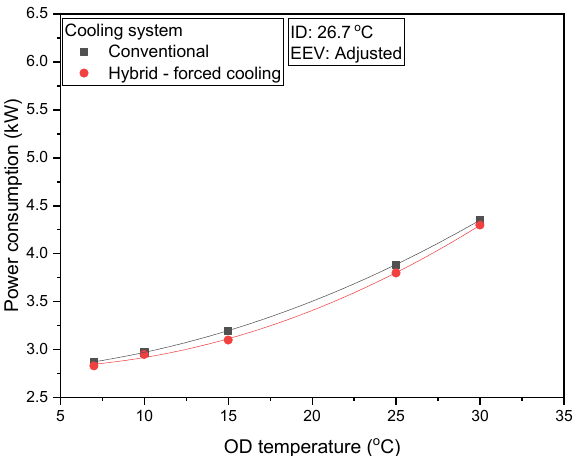
Figure 10. Saturation temperature comparison for novel hybrid IDC cooling and conventional IDC cooling system.